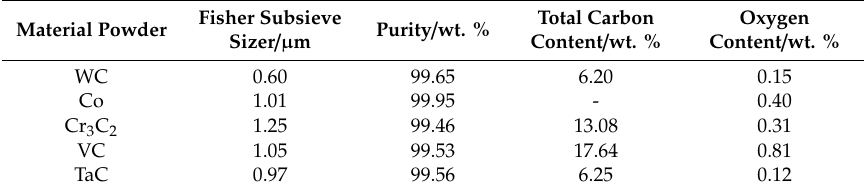
Table 1. Characteristics of raw